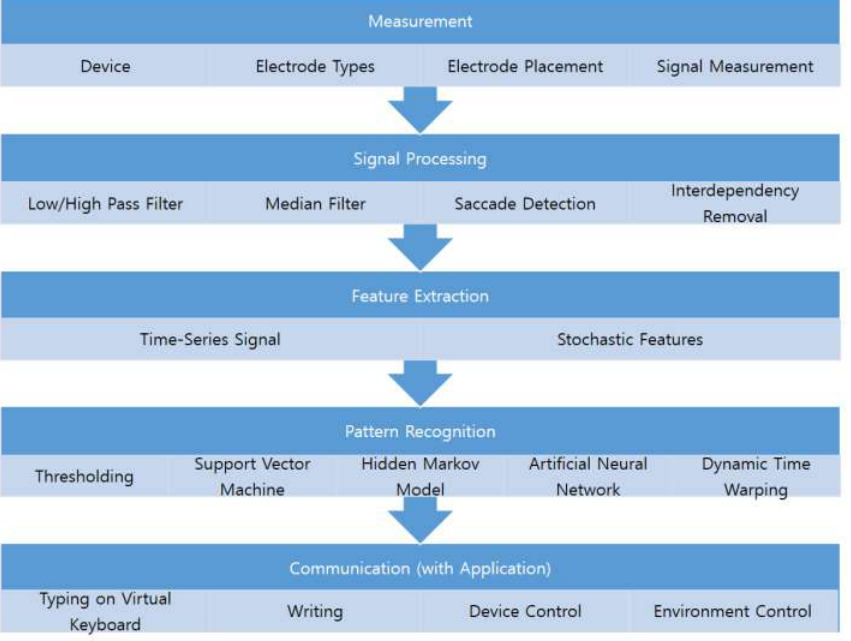
Figure 2. Overall Procedure of Utilizing EOGs for Human–Computer Interface.